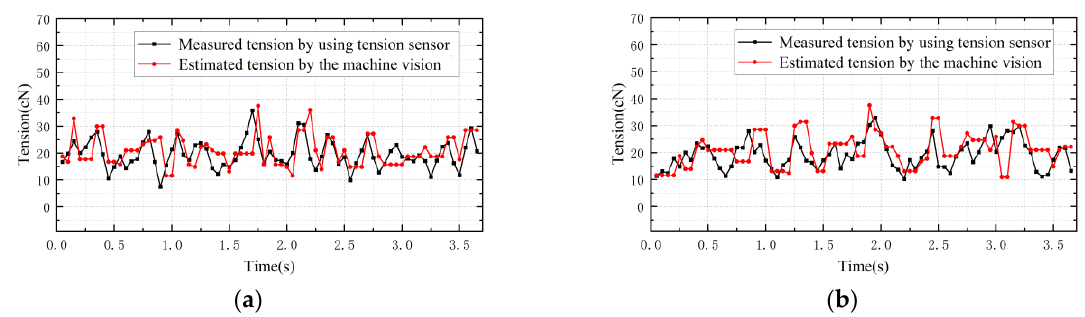
Figure 15. The sampling period is 0.05 s. ( a ) Motor speed is 100 r/min. ( b ) Motor speed is 150 r/min.